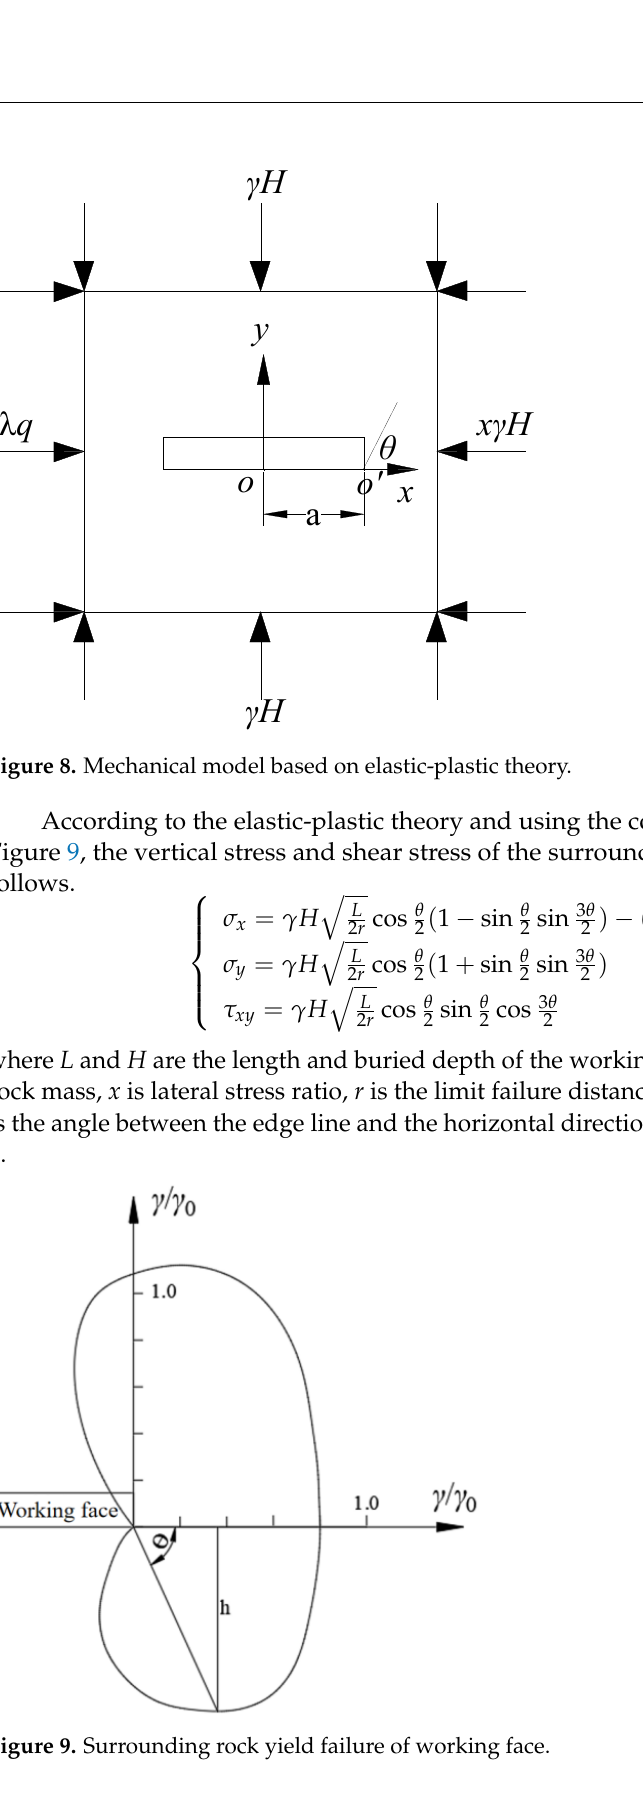
Figure 9. Surrounding rock yield failure of working face. According to the actual mining situation of the Sheng’an coal mine, the lateral pres- sure coefficient is 1, and then the principal stress expression of the stope edge can be de- duced as follows.